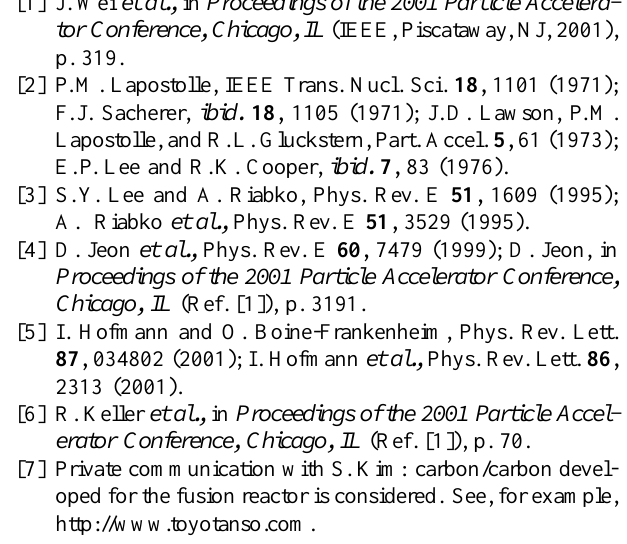
FIG. 21. (Color) Real space beam distribution at the end of DTL tank 1 for one set of random machine imperfections. The result- ing asymmetric scraping leaves a significant